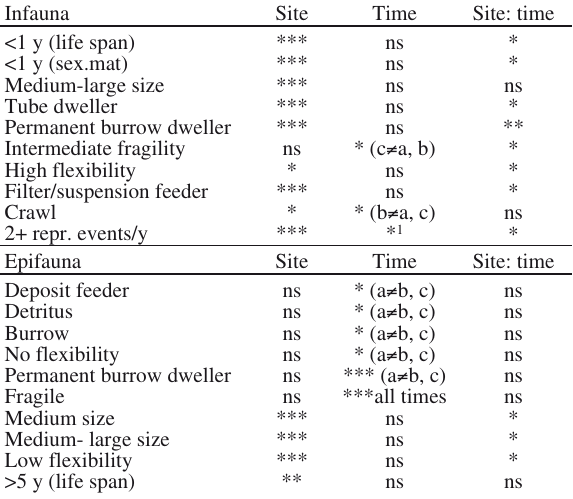
Fig. 6. Mean (±SE) trait abundance of epifauna at fished (black bars) and control sites (grey bars). Dashed line shows fishing effort. June corresponds to before closure period, July and August to closed season and September and November to after closure period. Table 6. – Summary of ANOVA/Kruskal-Wallis and pairwise tests for traits highlighted by SIMPER routine (traits showing a ratio of dissimilarity to standard deviation [diss/sd] >1.5 and being among the 50% of total contribution). * p<0.05, ** p<0.01, *** p<0.0001, ns, non-significant; b, before closed; c, closed season; a, after closed 1 ; the specific comparisons were not significant.